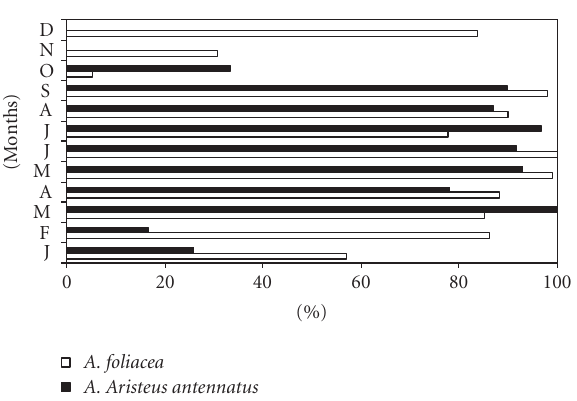
extended spawning period than Aristeus antennatus , in which reproduction processes seem to be more